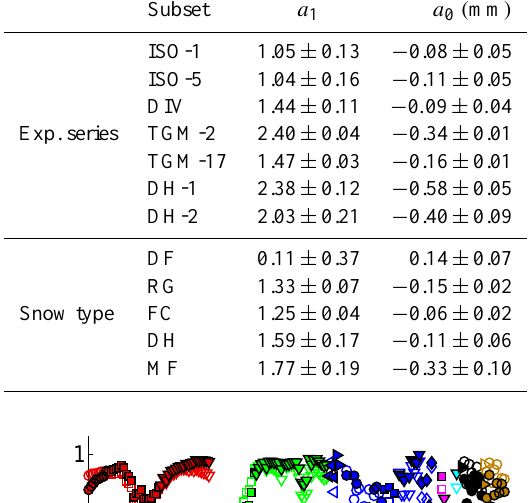
Table 1. Fit parameters and standard errors for a linear regression between the optimal SHS diameter and the optical diameter accord- ing to Eq. (40) carried out for subsets of the data: for individual experiment series (top) and for individual snow types (bottom).